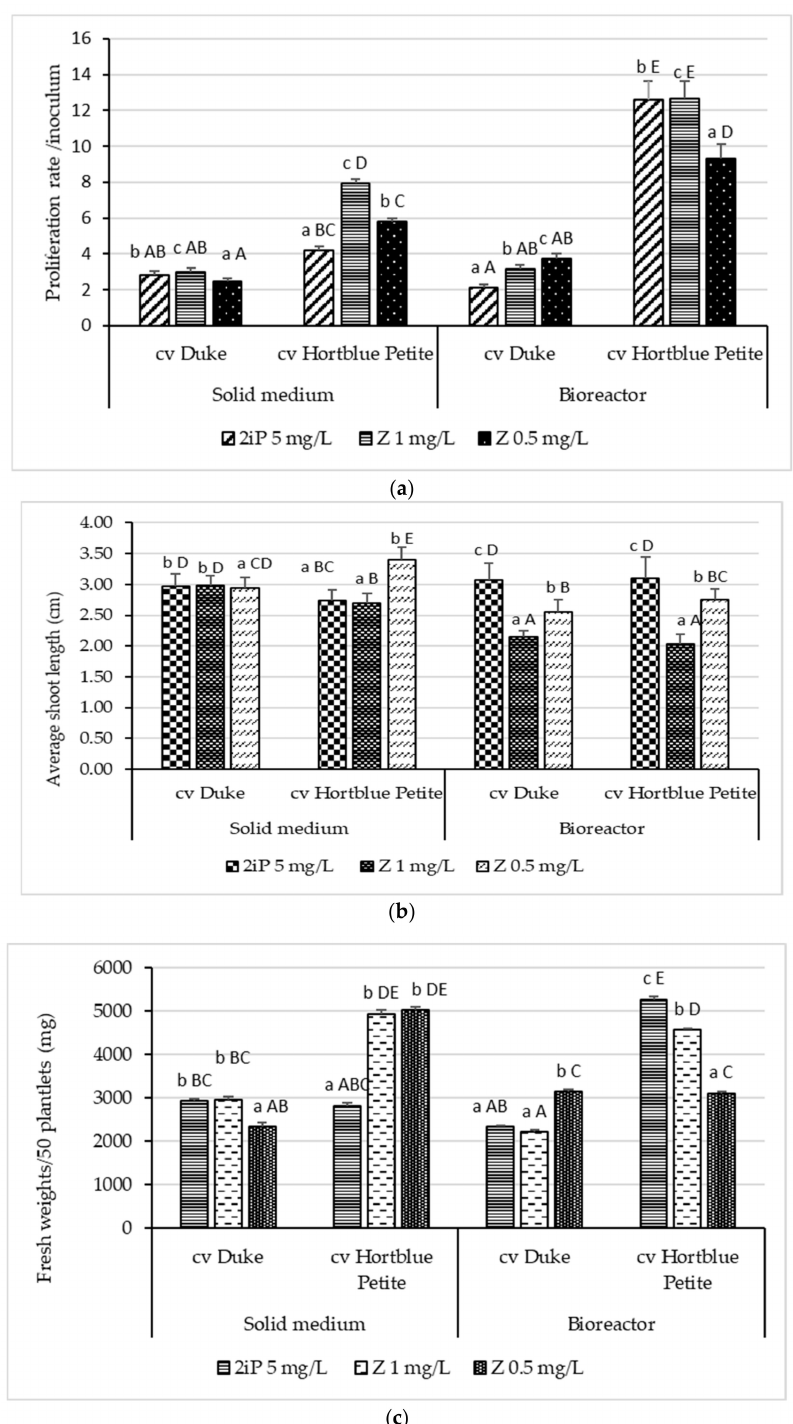
Figure 2. Measured growth parameters in the highbush blueberry ( V. corymbosum L.) cvs Duke and Hortblue Petite after 12 weeks of in vitro culture in solid and liquid media (McCown’s Woody Plant (WPM) medium supplied with 0.5 mg/L zeatin (Z), 1 mg/L Z and 5 mg/L N6-(2-Isopentenyl) adenine (2iP)). ( a ) Proliferation rate; ( b ) Average length of shoots (cm); ( c ) Fresh weights/shoots from 50 initial explants (mg). The values shown are means ± S.E. Different lowercase letters indicate significant differences between the means of the same cultivar considering the three types of growth regulators, individually for both types of medium (solid and bioreactor/liquid). Capital letters indicate significant differences between the means of all analysed samples, according to Tukey’s HSD test ( p <